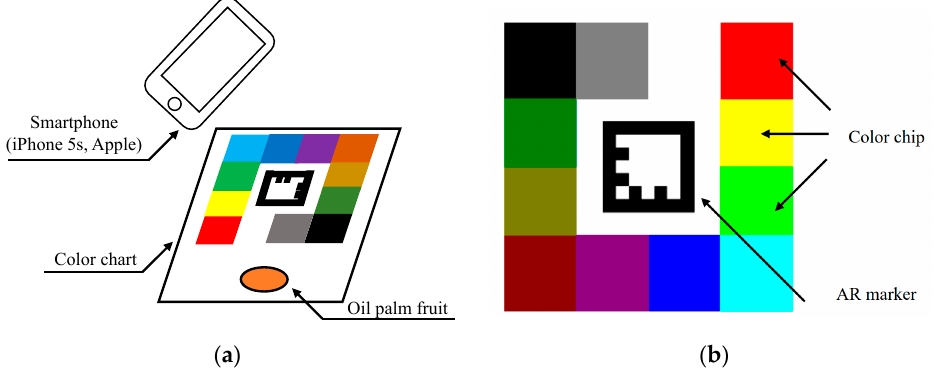
Figure 4. ( a ) Experimental setup of computer vision and ( b ) augmented reality (AR) marker-based color chart for automatic color correction.